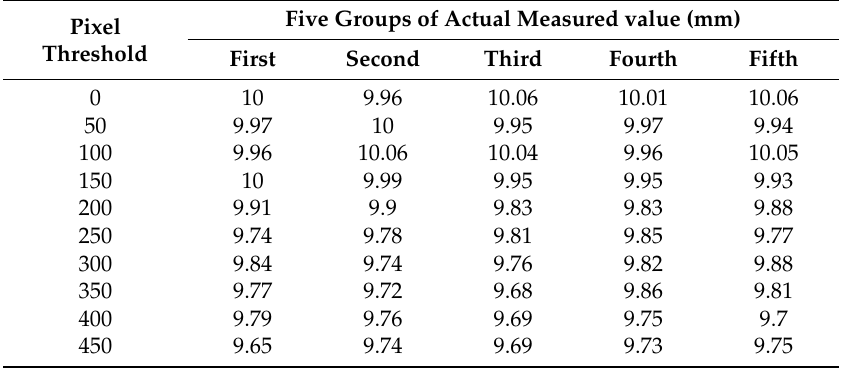
Table 3. The effect of pixel threshold on measurement value: actual measured value.